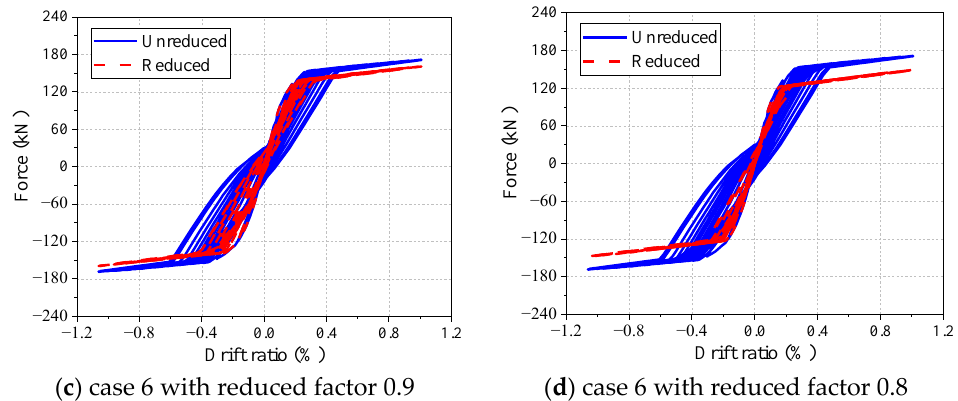
Figure 10. Hysteretic curve of the numerical models with reduced yielding strength.